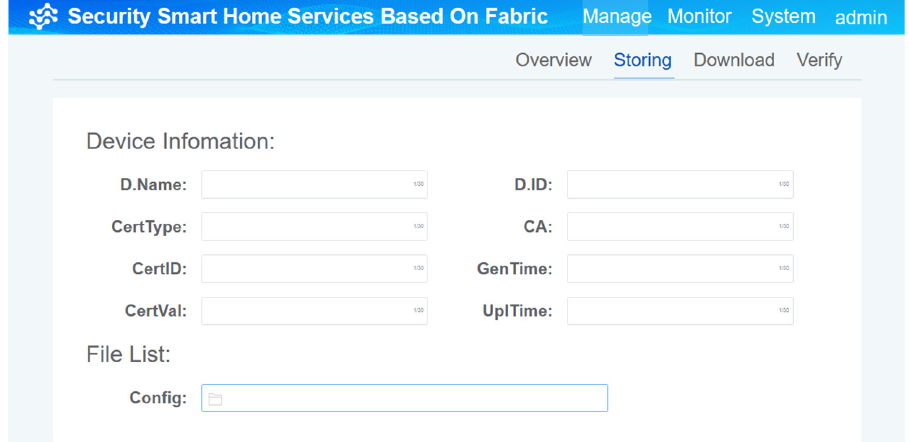
Figure 10. The process of writing device certificates and key information on the chain.